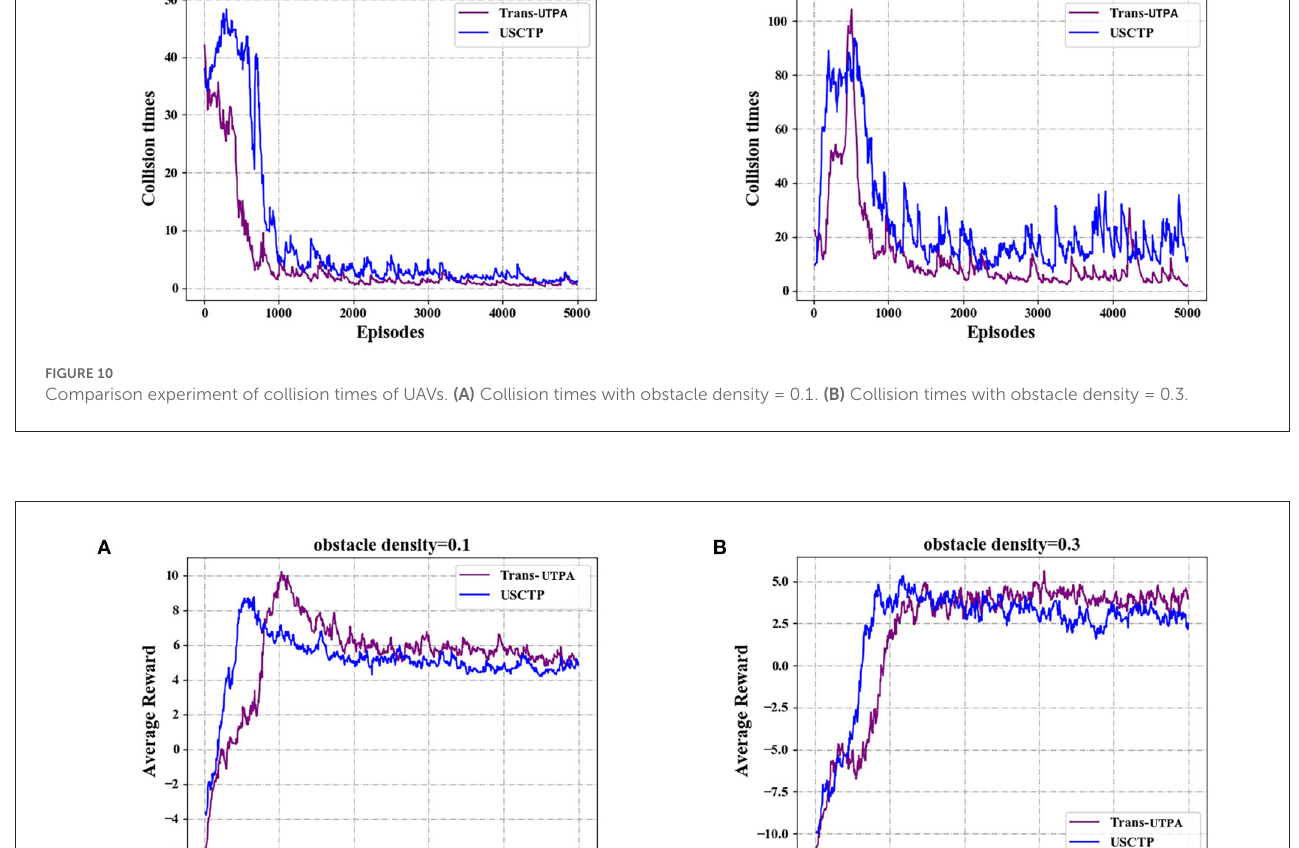
the mission in the same flight area. From the figure, we can find that the TUTPA algorithm can access more target-POI at the same time, because the TUSCTP algorithm can mobilize the UAV to